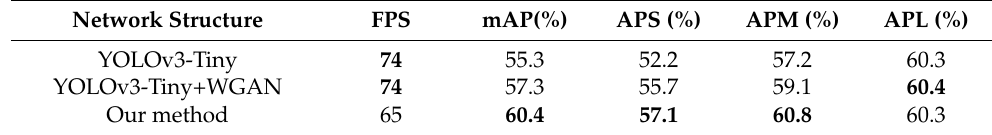
Table 6. The test results with and without WGAN.